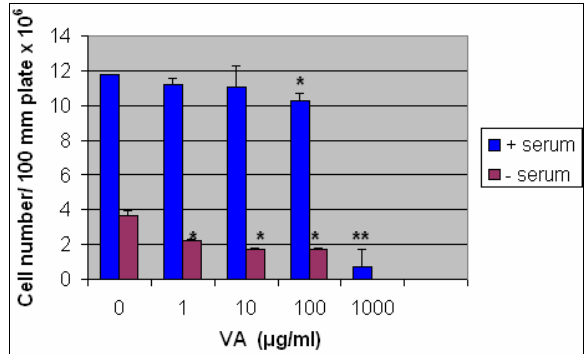
Figure 2: Inhibition of cell proliferation by VA extracts in the presence and absence of serum. Cells at the logarithmic growth phase were treated with various concentrations (0 – 1000 µg/ml) VA for 24 h. Followed by cell counts as described under the materials and methods section. Each data point represents the mean of three independent experiments done in duplicates (N=6). *p < 0.05, **p <0.001.